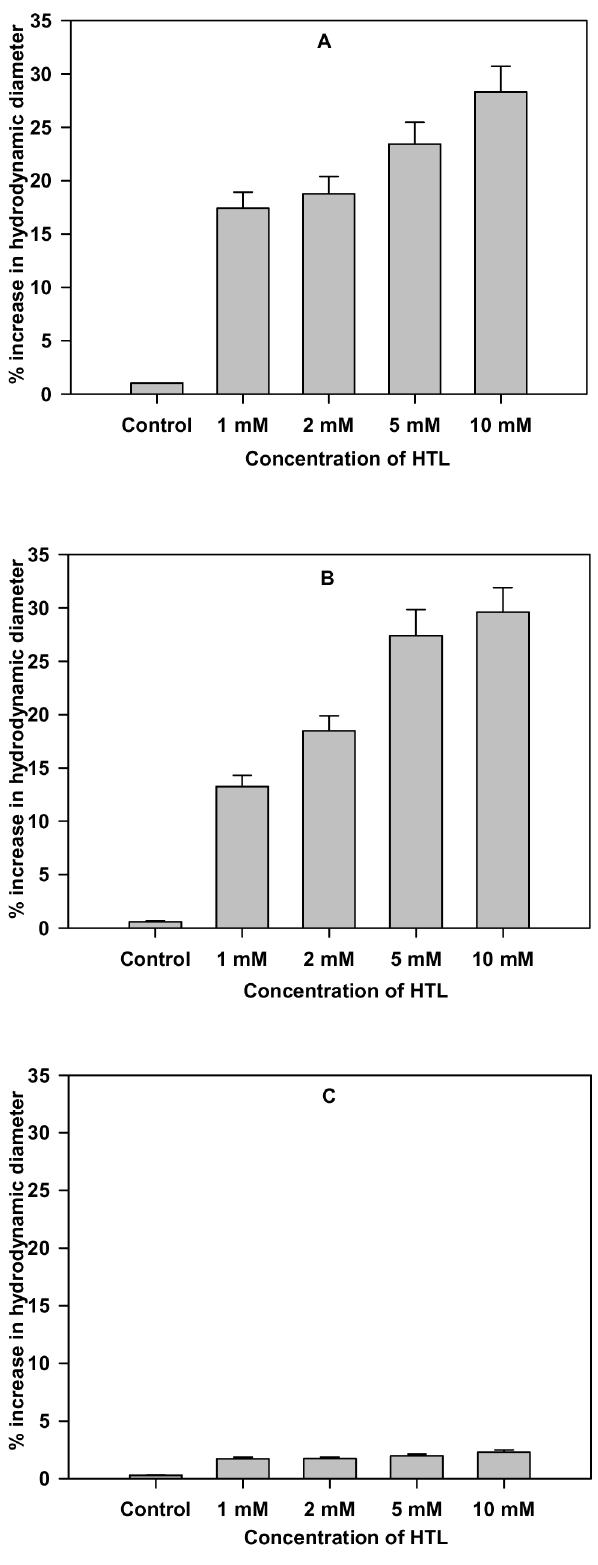
Figure 1. Effect of homocysteine thiolactone (HTL) on the hydrodynamic diameter of the native state of proteins. Percent increase in hydrodynamic diameter of (A) cyt-c (at 18 hours) and (B) a - LA (at 4 hours) and (C) lysozyme (at 24 hours) after modification with different concentrations of HTL.